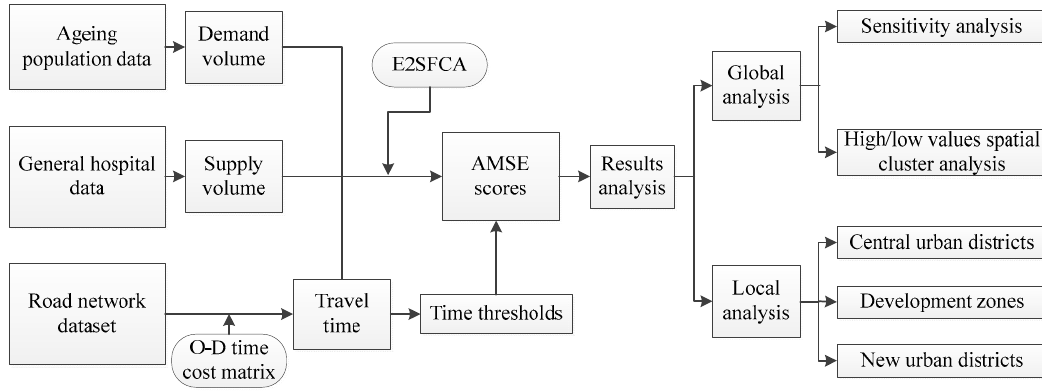
Figure 3. Research process flow chart; E2SFCA: the road network-based Guassian 2SFCA method; O–D: origin to destination.